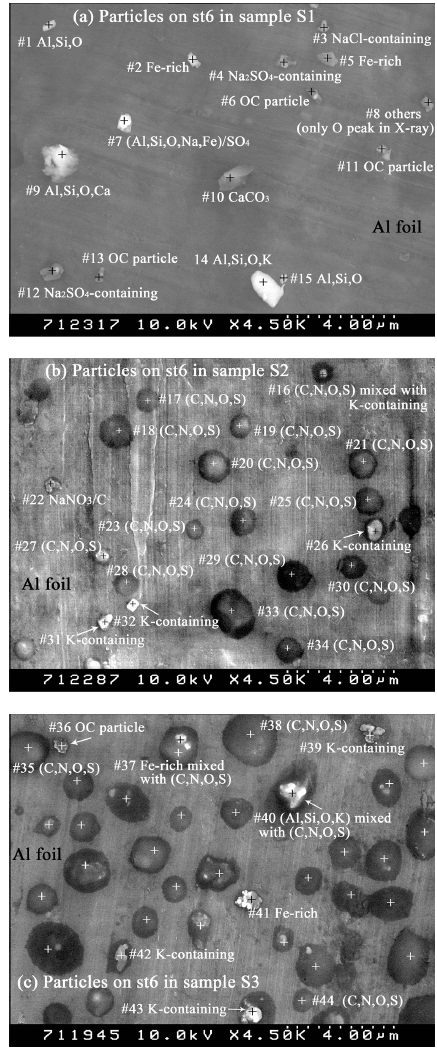
Fig. 5. SEIs of typical particles on stage 6 in samples S1, S2, and S3. (For Fig. 5c, those with a “ + ” are all particles rich in C, N, O, and